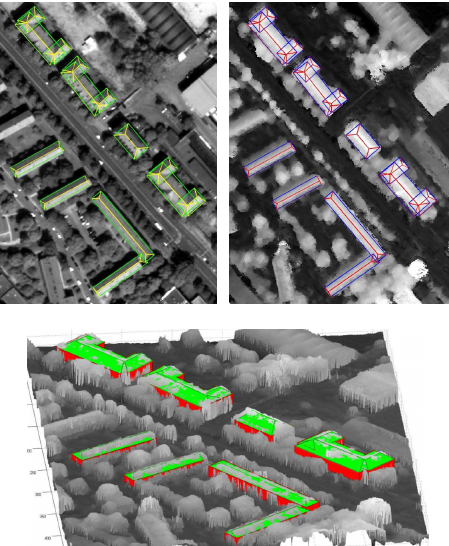
Figure 12: 3D Model of sample buildings in Munich city, Ger- many